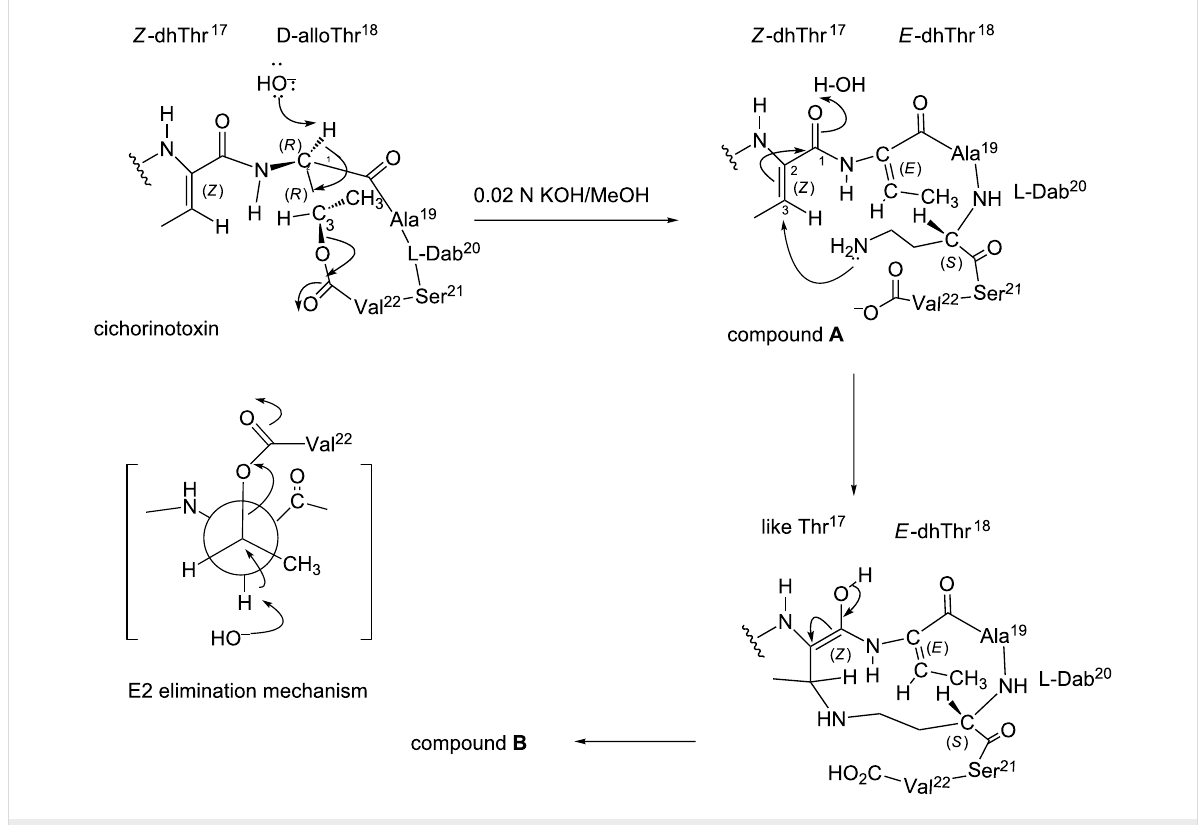
Figure 10: Mechanism of the formation of compounds A and B from cichorinotoxin by alkaline hydrolysis.